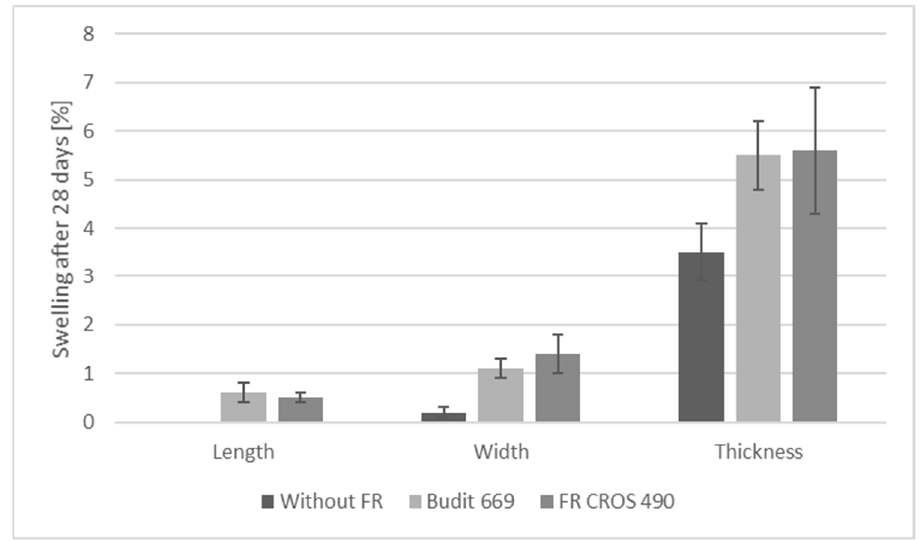
Figure 12. Swelling of co-extruded hollow core profiles after 28 days storage in cold water. Requirements according to Table 7 were fulfilled.